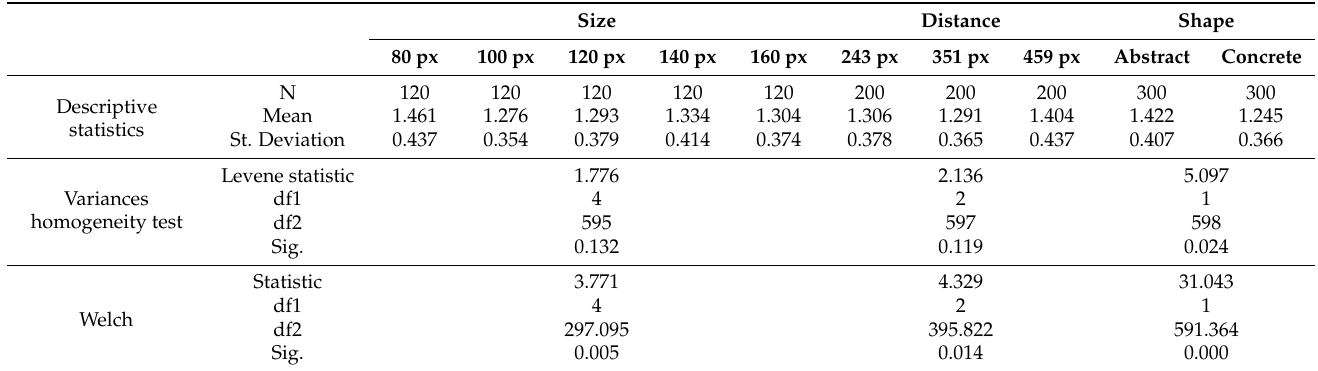
Table 2. One-way Welch’s ANOVA results for reaction times of size, distance, and shape factors. Size Distance Shape 80 px 100 px 120 px 140